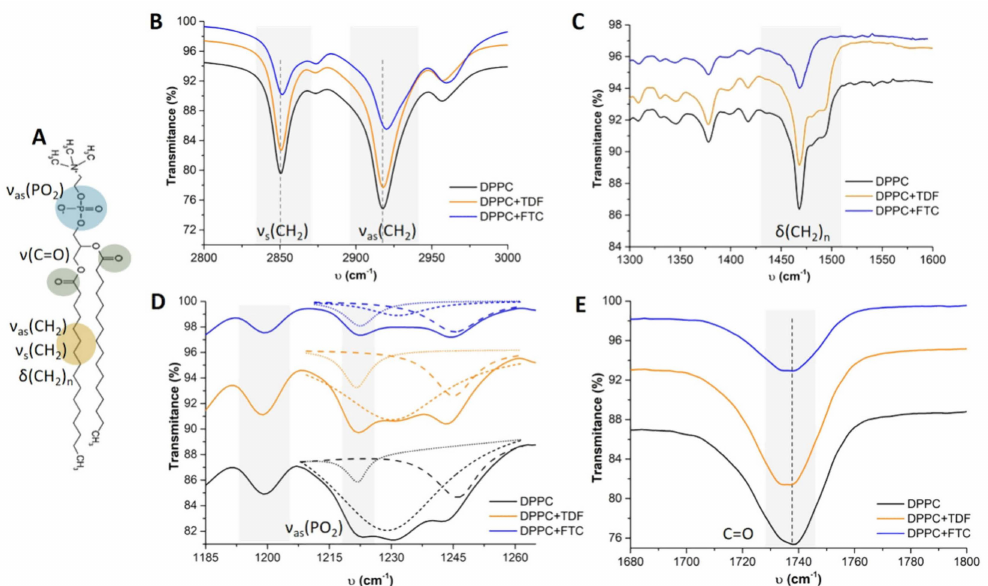
Figure 4. ( A ) DPPC phospholipid showing the chemical groups responsible for the main infrared vibration modes; ( B – E ) show attenuated total reflection–Fourier transform infrared (ATR–FTIR) spectra obtained for DPPC membranes in the absence (black) or in the presence of TDF (yellow) or FTC (blue) for di ff erent vibration modes: υ (CH 2 ) stretching modes ( B ); δ (CH 2 ) n scissoring vibration mode ( C ); υ as (PO υ (C = O) stretching mode ( E ). In panel ( D ), dashed lines represent 2 ) stretching mode ( D ); and the deconvolution of the bands performed to determine with precision the area of the band located at 1221 cm − 1 required to subsequent calculation of the ratio a 1221 / a 1201